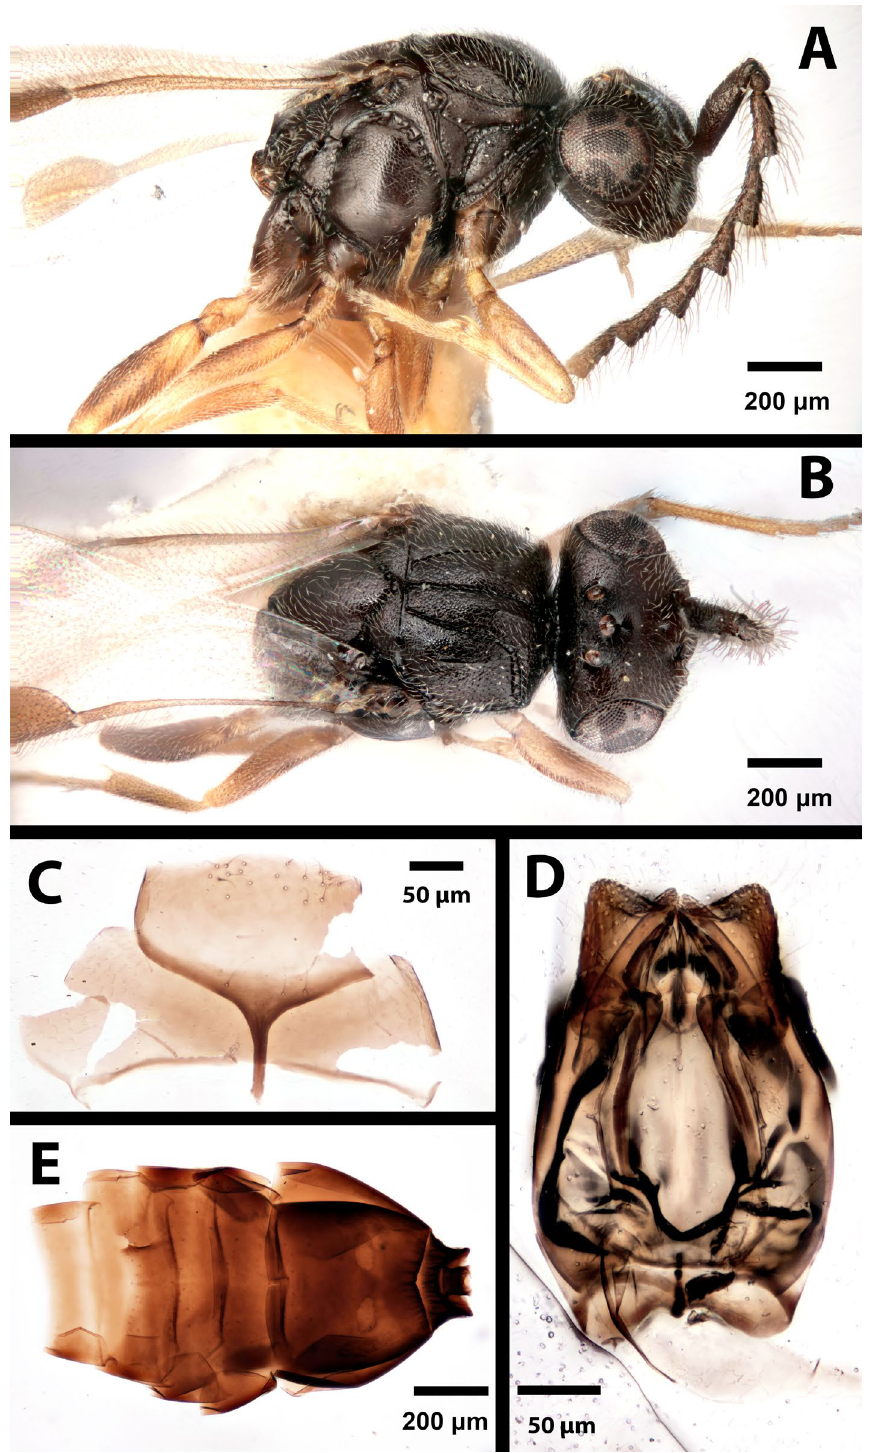
Fig. 24. Dendrocerus remaudierei Dessart, 1974, holotype, ♂. A . Lateral habitus (MNhN EY25335). B . Dorsal habitus (MNhN EY25335). C . Dorsal view of male S9 (MNhN EY22468). D . Ventral view of male genitalia (MNhN EY22469). E . Ventral view of metasoma (MNhN